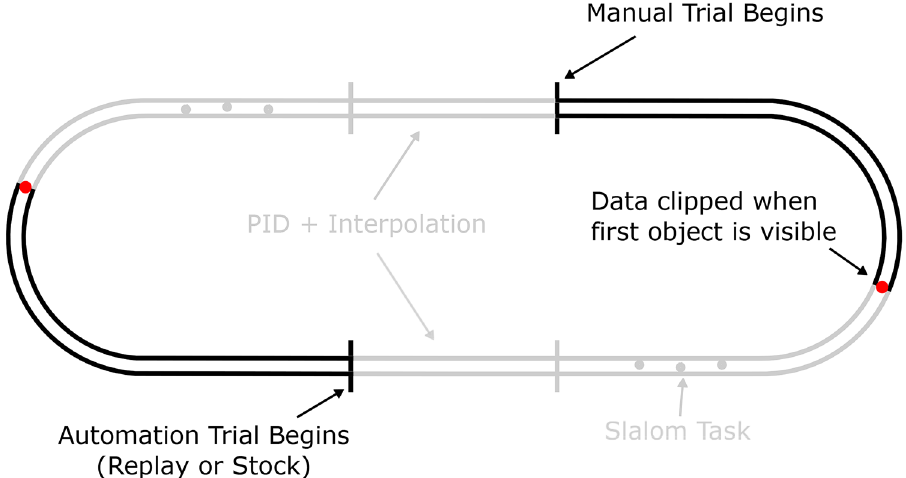
Figure 12. Annotated track. Driving was along a continuous track consisted of two 120 m straights and two bends of 25 m radius, with a road width of 3 m and at a speed of 8 m/s. The task alternated between Manual and Auto(mated) periods (Black). These periods were connected using an interpolation period that consisted of 4.5 s (36 m) of self-controlling PID control that smoothly brought the vehicle back to a central lane position, with a final .5 s (4 m) of linear interpolation of yaw, steering wheel, and lane position to ensure that the initial state precisely matched the beginning state of the next period. Gaze data were excluded from the frame where